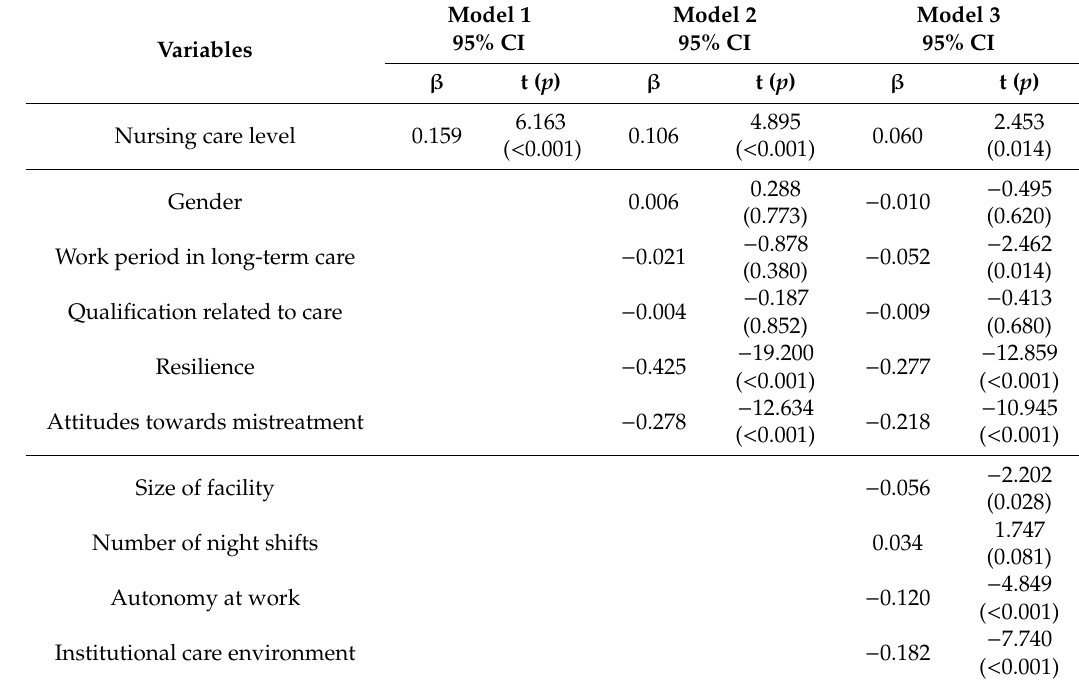
Table 3. Hierarchical regression analysis of factors a ff ecting mistreatment ( n =